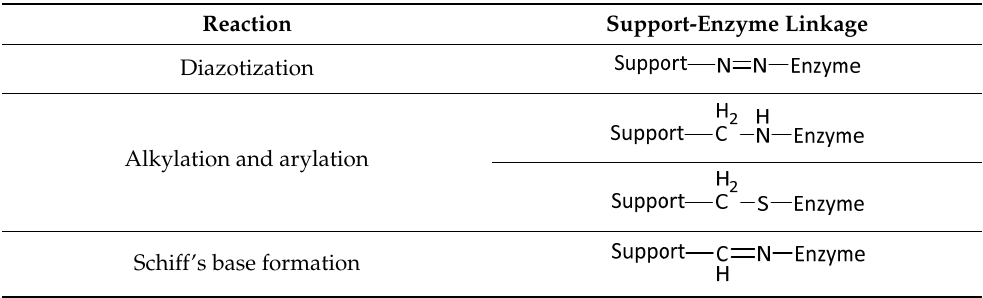
Table 2. Different methods for covalent binding of enzymes to supports [35,111–114].